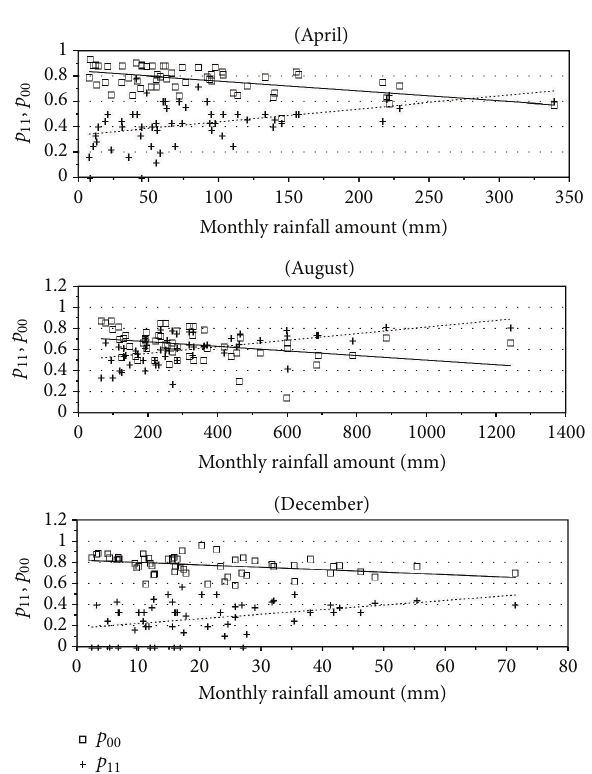
Figure 3: Sample regression lines of transition probabilities 𝑝 11 and 𝑝 00 estimated with respect to monthly rainfall amounts.